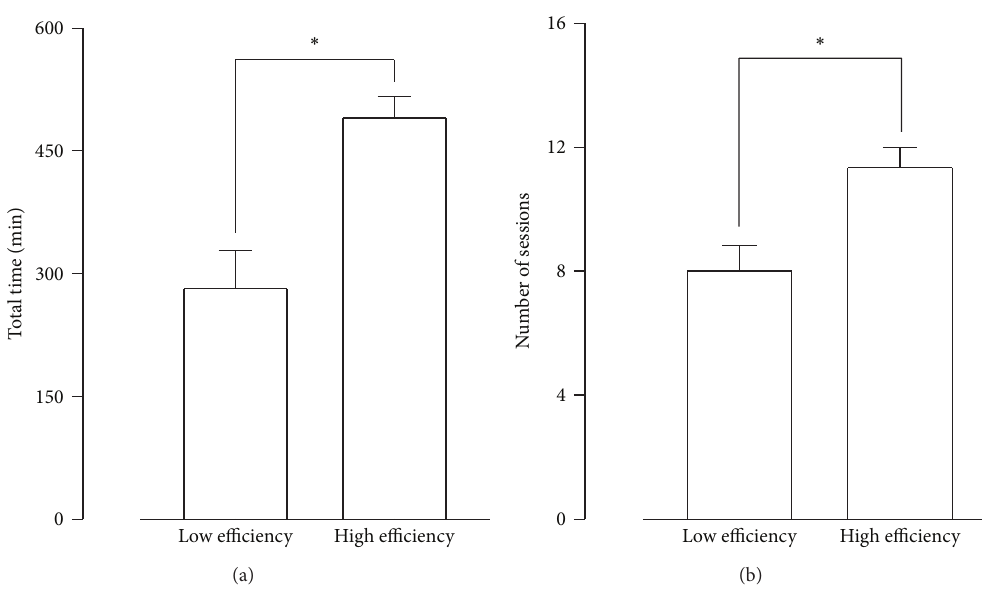
Figure 2: Differential characteristics of virtual reality protocols according to average efficiency. (a) Time spent in virtual reality-based treatment. (b) Number of sessions depending on the clinical impact of the treatment (“low efficiency” defining studies with less than 20% of